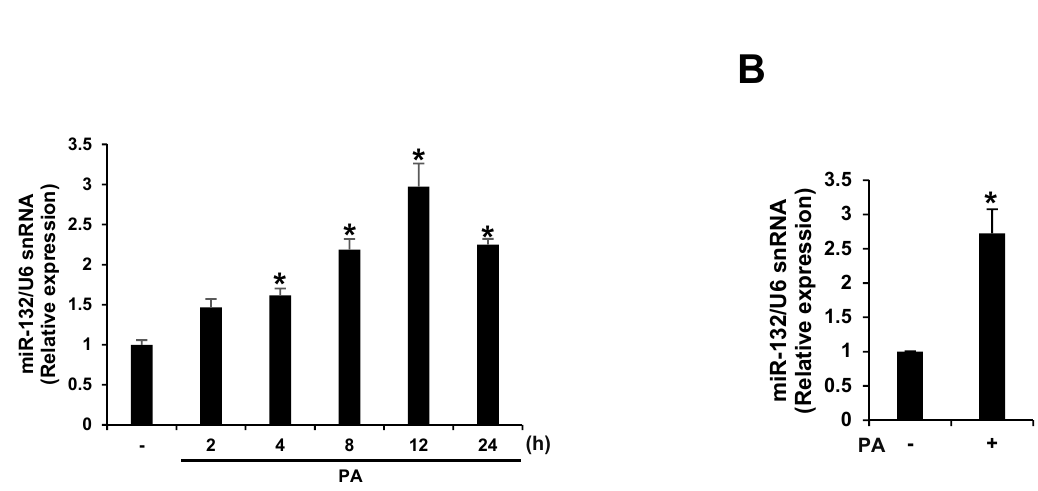
Figure 2. PA up-regulates miR-132 expression. ( A ) THP-1 cells were treated with 200 µ M PA for 2, 4, 8, 12, and 24 h; ( B ) Primary murine macrophages were treated with 200 µ M PA for 12 h. miR-132 expression was analyzed by quantitative RT-PCR. * p < 0.05 compared with PA-untreated cells.